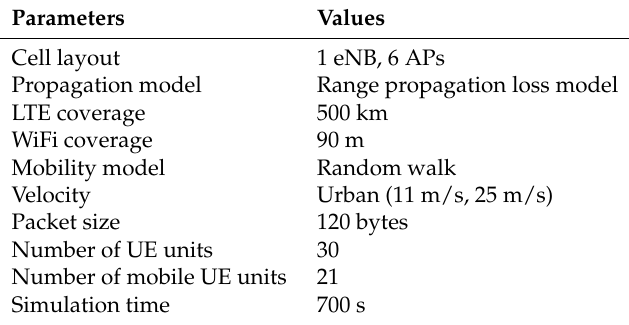
Table 1. Simulation parameter